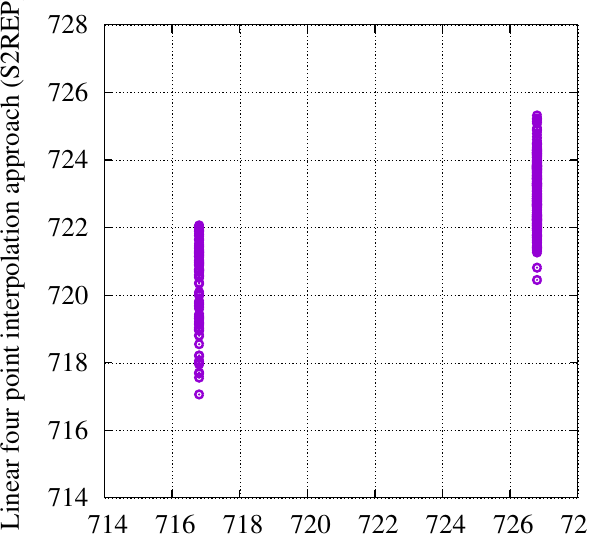
Figure 5. Comparison of two methods for estimating the red-edge inflection point. The location of red-edge inflection point estimated according to its mathematical definition as the location of the maximum of the first derivative is shown on the x-axis and the result of linear four-point interpolation approach (S2REP) is displayed on the